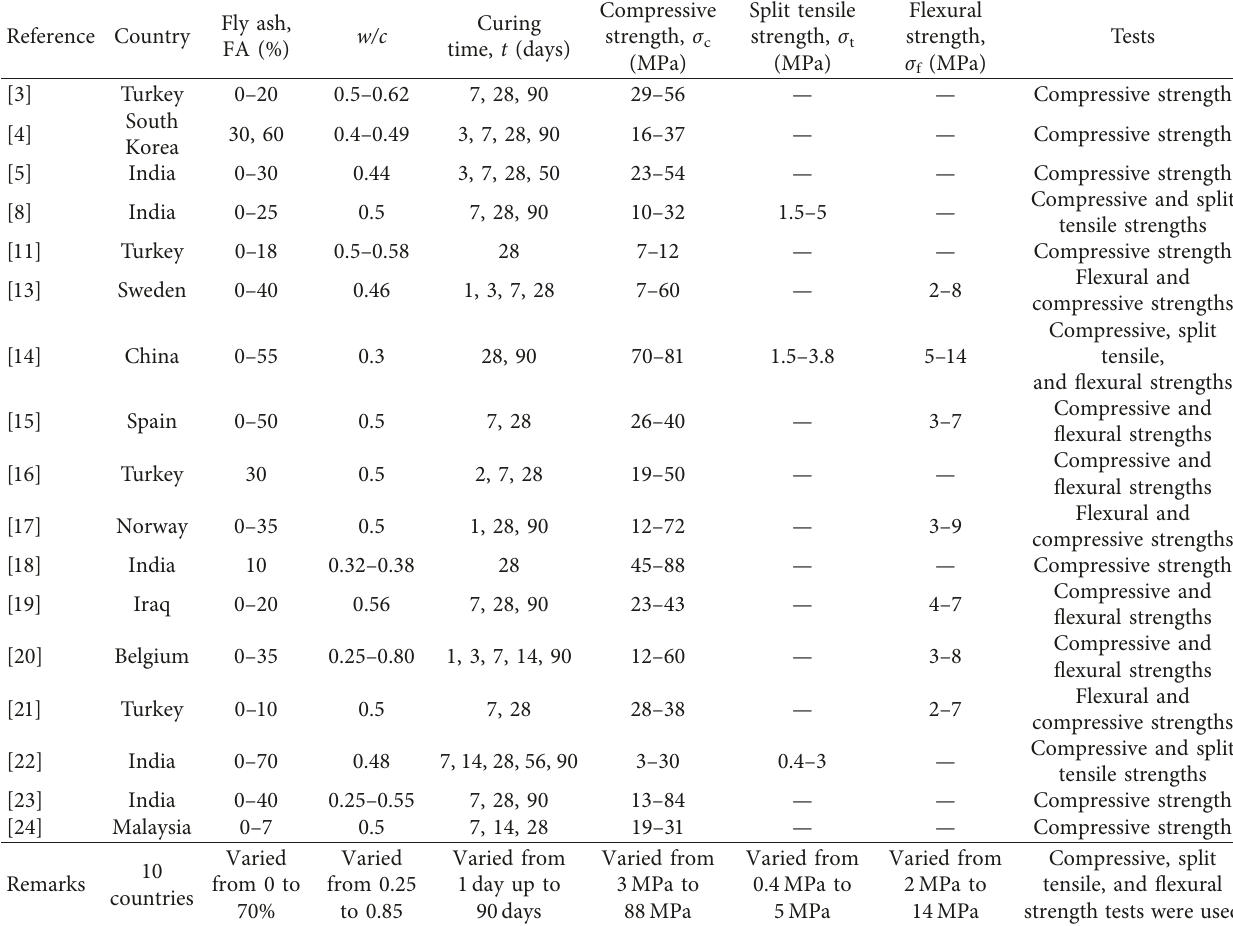
Table 1: Summary properties of cement mortar modified with fly ash. Reference